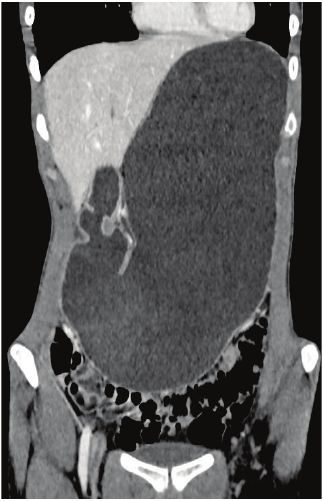
Figure 2: Coronal CT section demonstrating gross distension of the stomach.